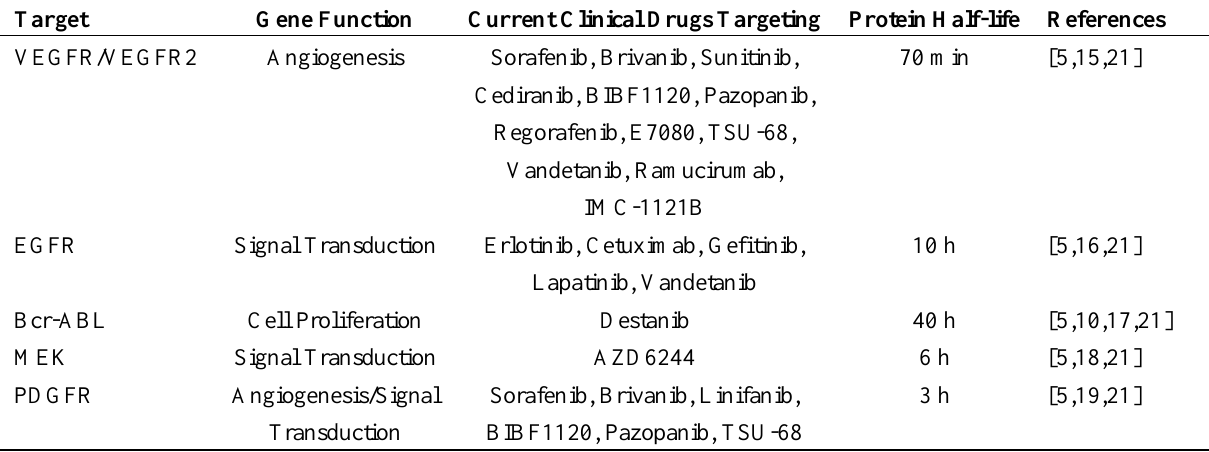
Table 1. Overview of some HCC